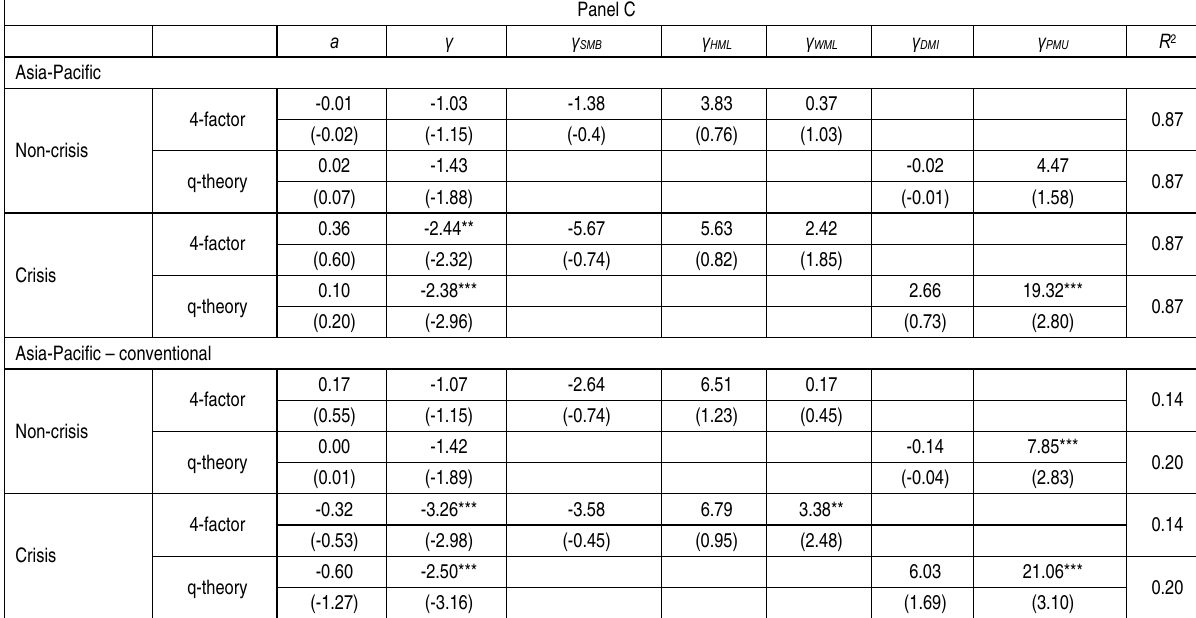
Table 5 (cont.). Managerial abilities of North American, European, and Asian-Pacific